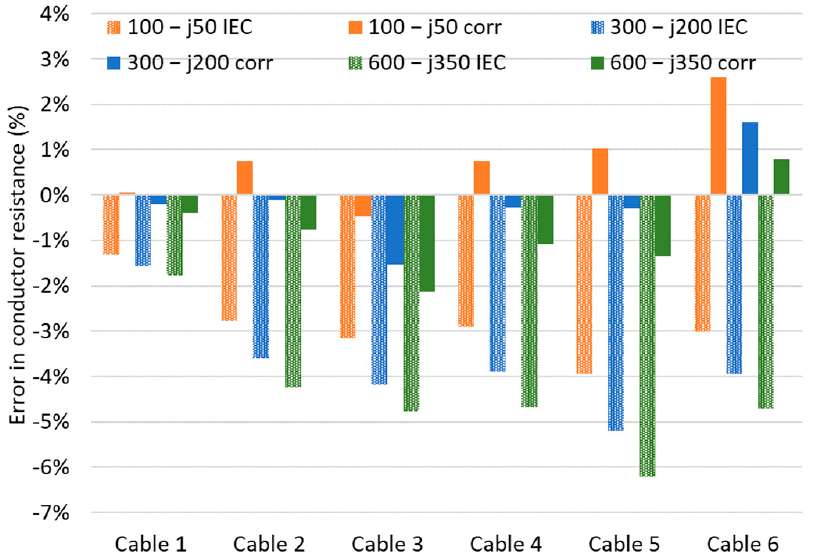
Figure 13. Error in conductor resistance, relative to FEM solutions, of the results derived from the formulation provided by [5] and the proposed approaches.